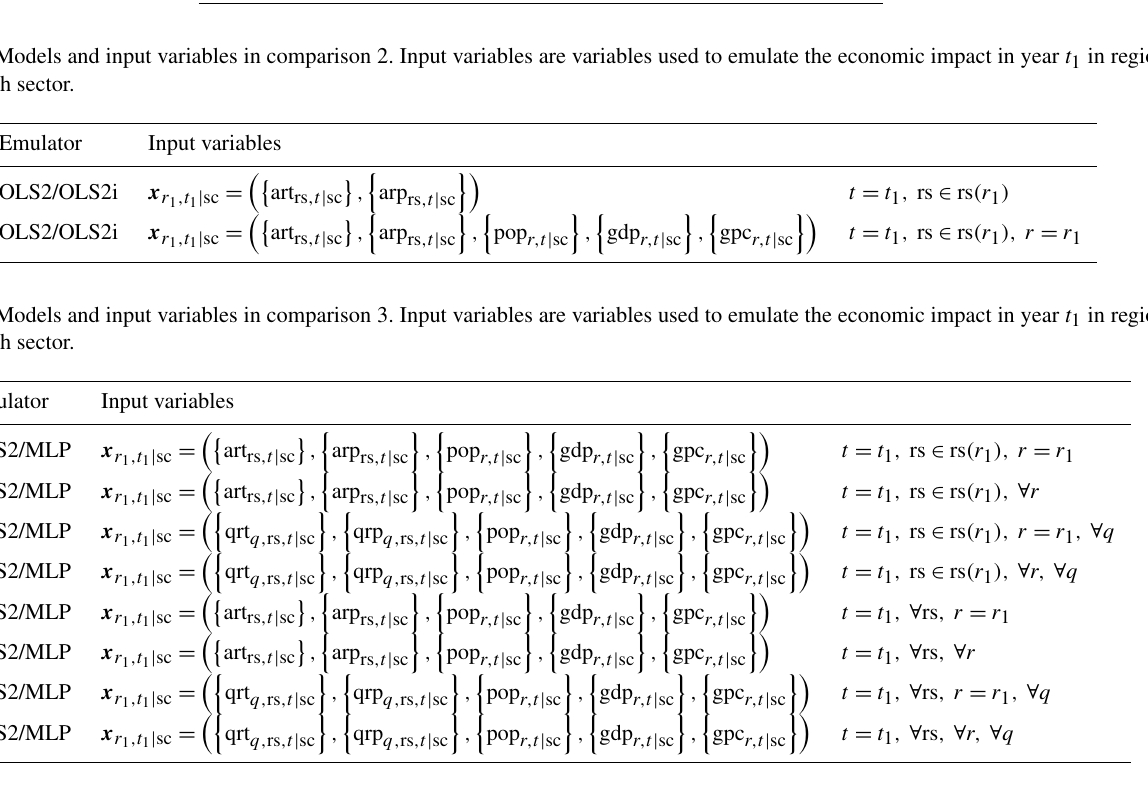
Table 6. Models and input variables in comparison 4. Input variables are used to emulate the economic impact in year t 1 in region r 1 for each